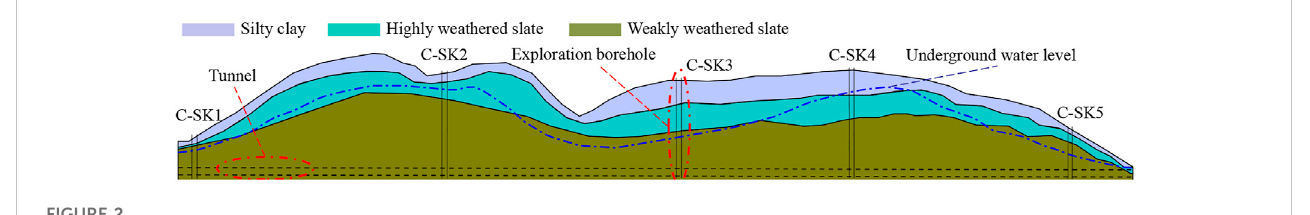
FIGURE 2 Geological pro fi le.